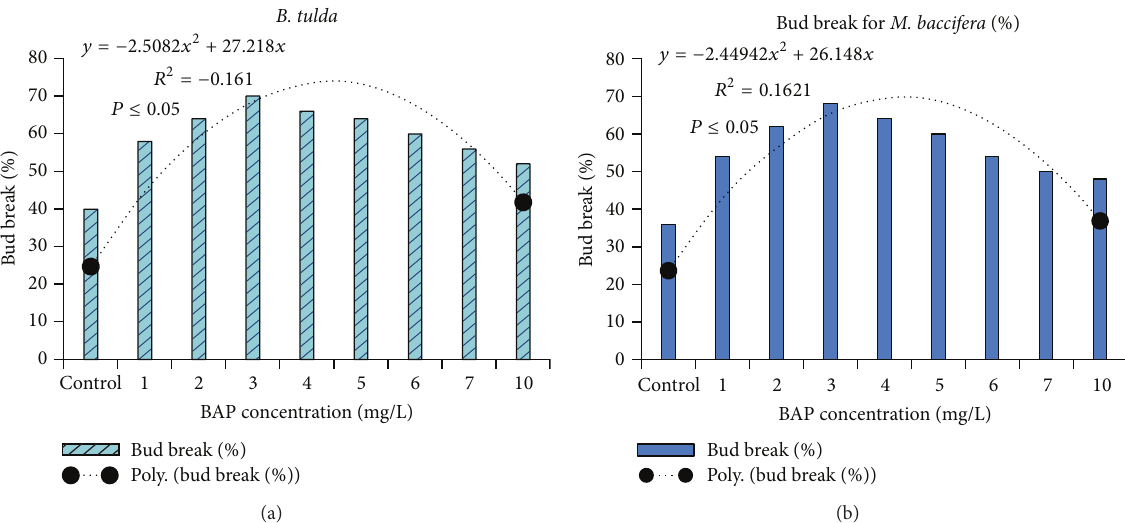
Figure 2: Effectiveness of BAP on bud break in MS medium revealed 3 mg/L is the optimum concentration. (a) Bambusa tulda . (b) Melocanna baccifera .